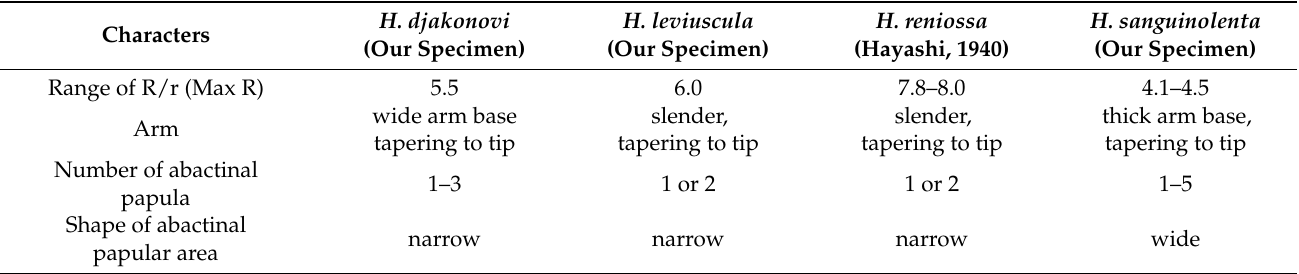
Table 1. Comparison of the morphological characteristics of H. djakonovi with those of related Henricia